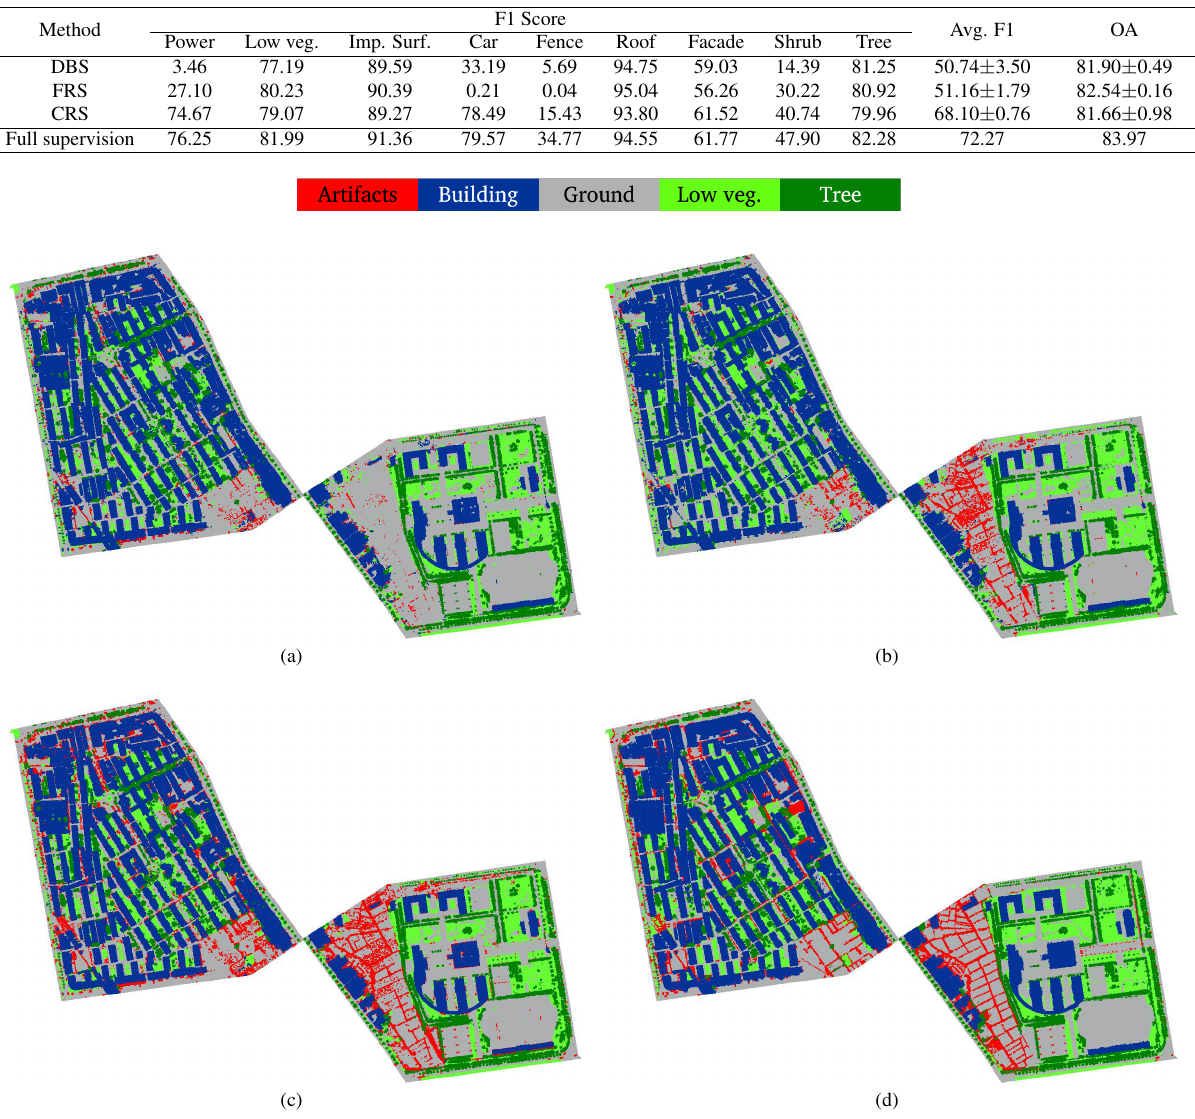
Table 4. Comparison of full and weak supervision schemes on the ISPRS dataset